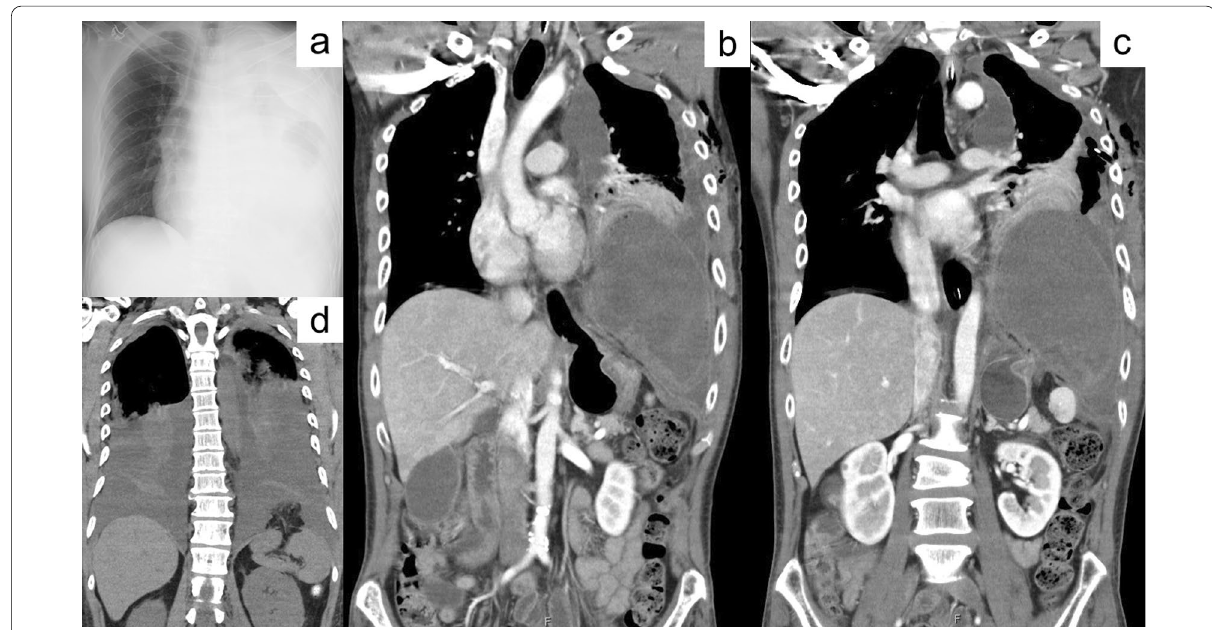
Fig. 1 Preoperative imaging findings. a Chest X-ray showing the opacity of the entire left lung field with pleural fluid and left intrathoracic free air. The trachea and mediastinum shifted to the right. b Coronal images of the enhanced computed tomography (CT) scan on admission revealed that the fundus and corpus of the stomach with reduced contrast enhancement herniated to the left thoracic cavity through a defect in the diaphragm. The cardia and pylorus of the stomach presented normal enhancement. c The left lung is excluded by the gastric content of the herniated body, intrathoracic free air, and pleural effusion. d A plain CT scan obtained during the patient’s previous admission showed a small defect in the left hemidiaphragm with a herniated